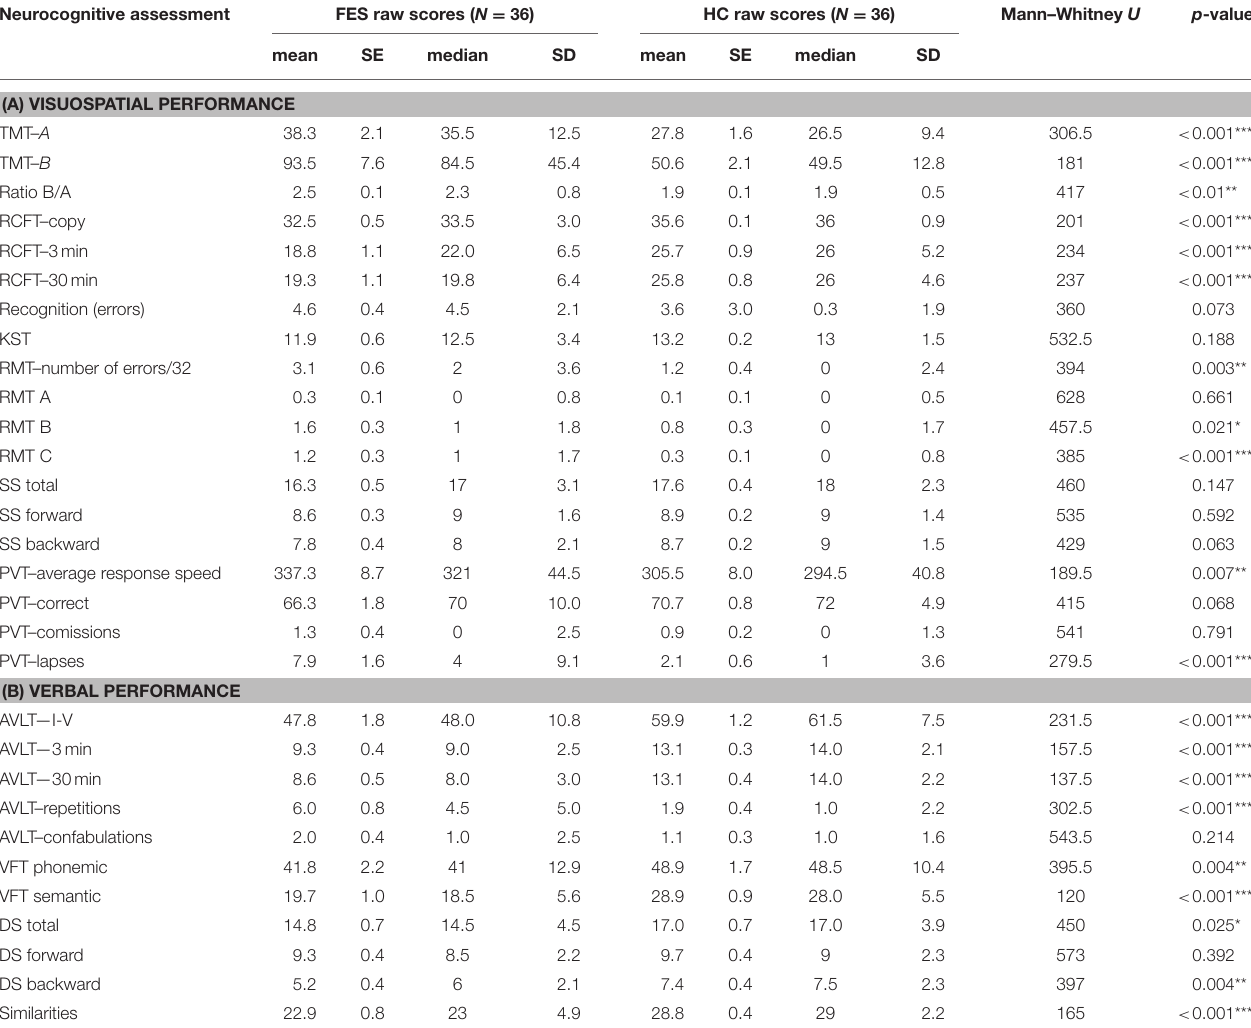
TABLE 3 | Group differences in (A) Visuospatial and (B) Verbal neurocognitive tests. Neurocognitive assessment FES raw scores ( N = 36 ) HC raw scores ( N = 36